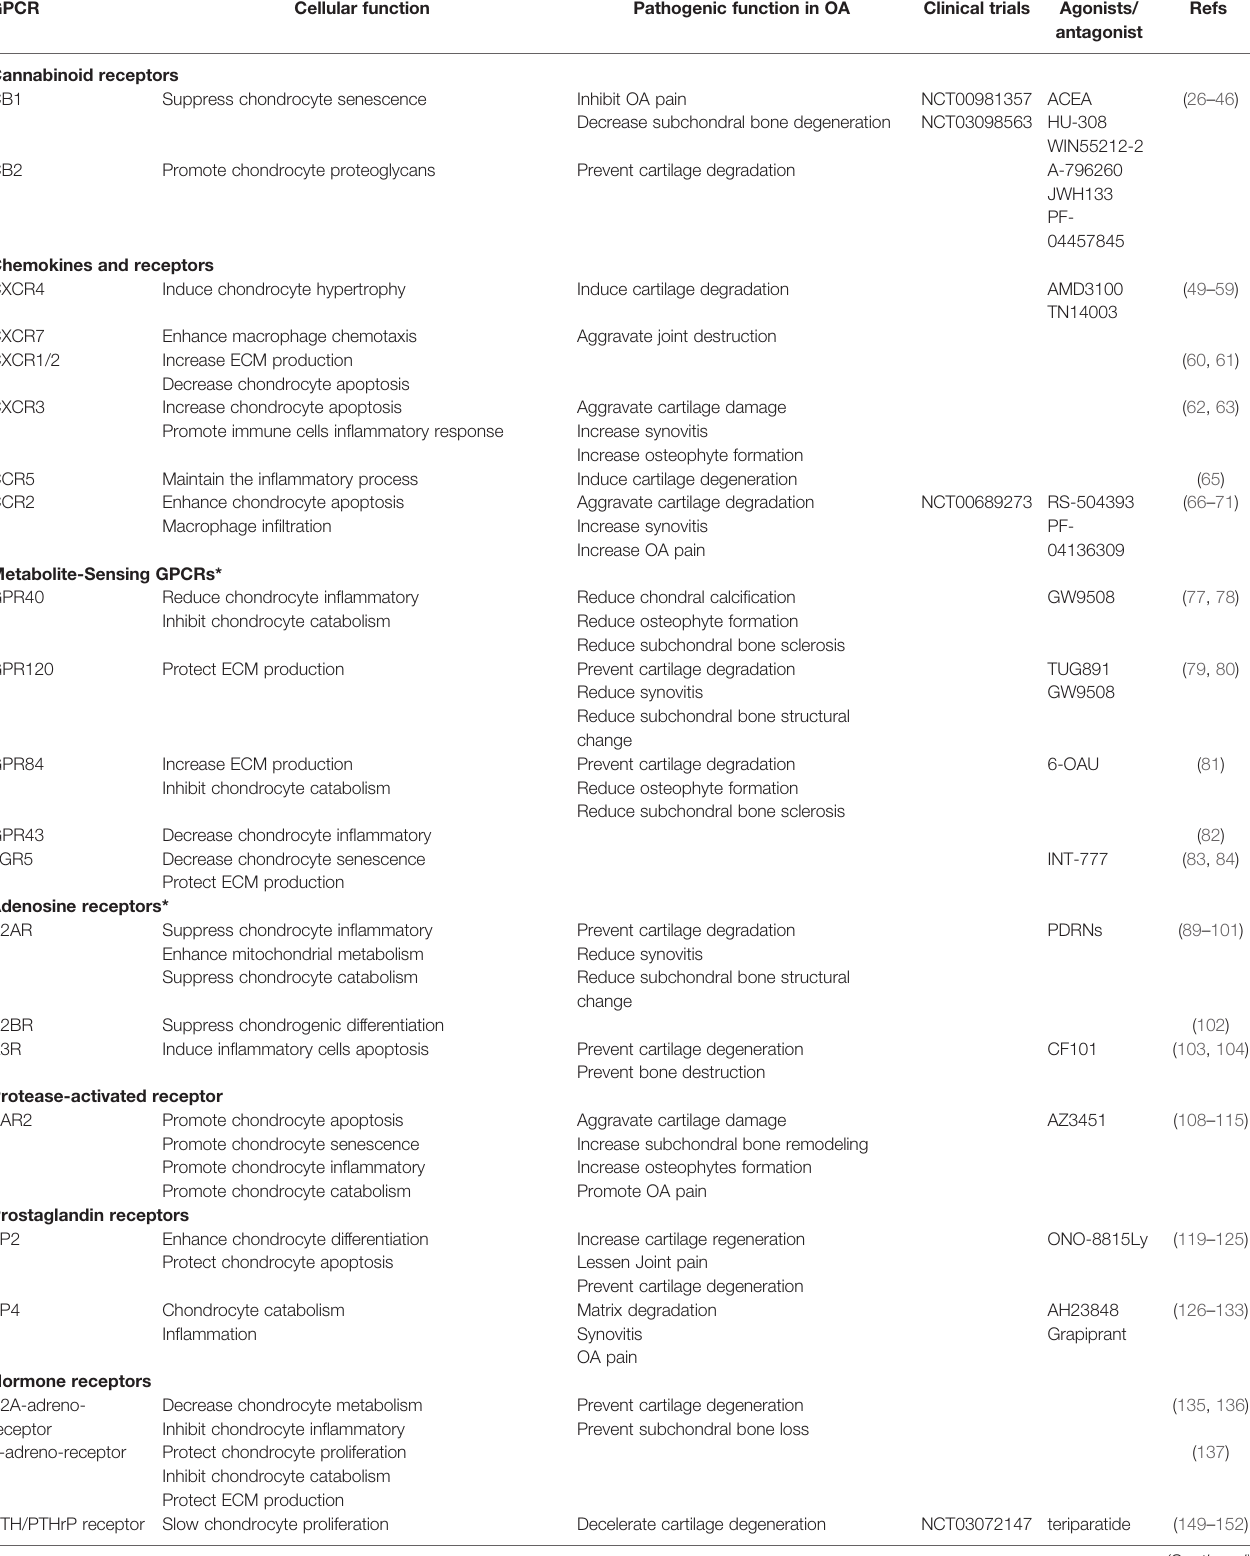
TABLE 1 | GPCRs relevant to